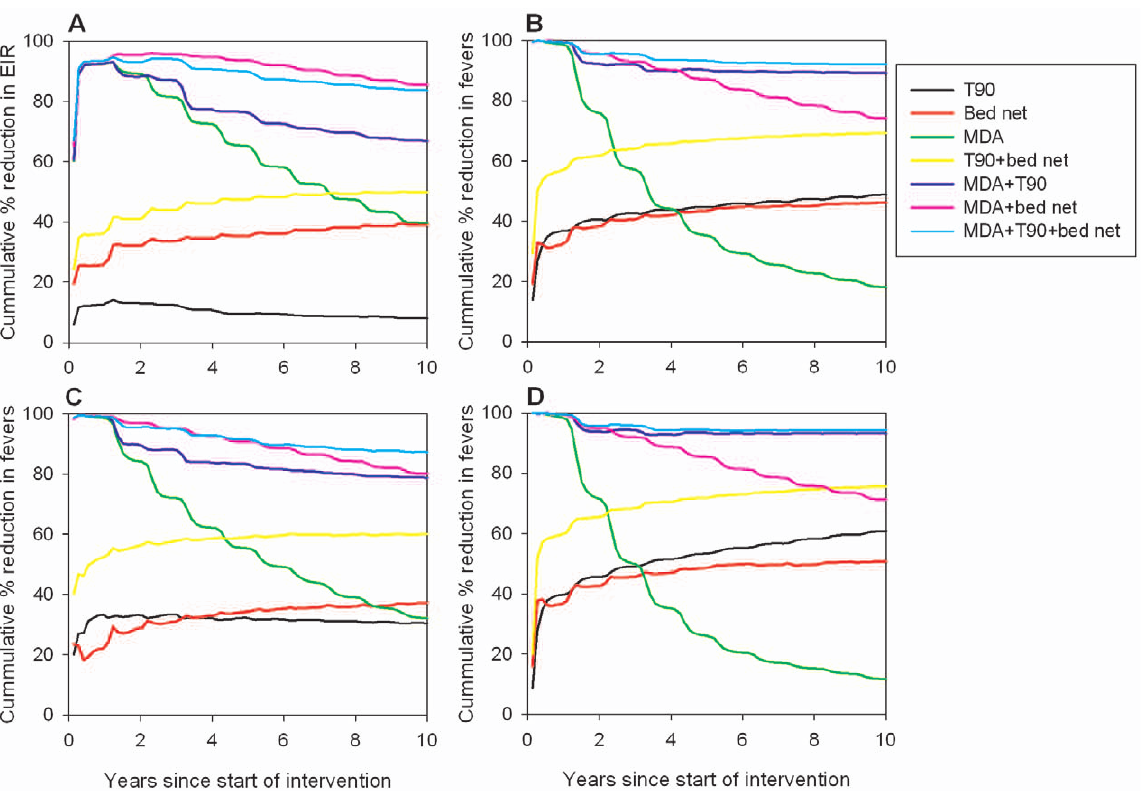
Figure 3. Average long-term impacts of interventions on EIR and morbidity. Impacts for (A) EIR, (B) population morbidity, (C) morbidity in 0–3 year olds and (D) . 14 year olds are given relative to baseline for moderate transmission simulations. Only results from simulations in which elimination was not achieved and sustained are included, reducing the sample sizes to n=3 and n=5 for the MDA + bed + T90 and MDA + T90 interventions, respectively.